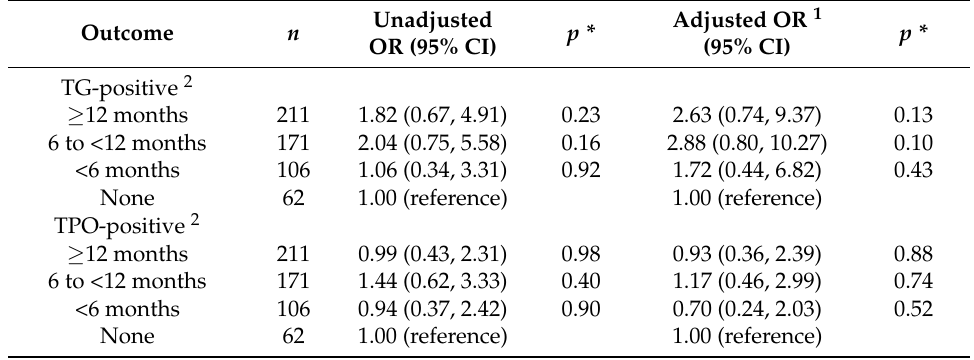
Table 2. Odds of thyroid autoimmunity 9 to 16 years postpartum according to lactation history among women with a history of gestational diabetes, Diabetes & Women’s Health Study.